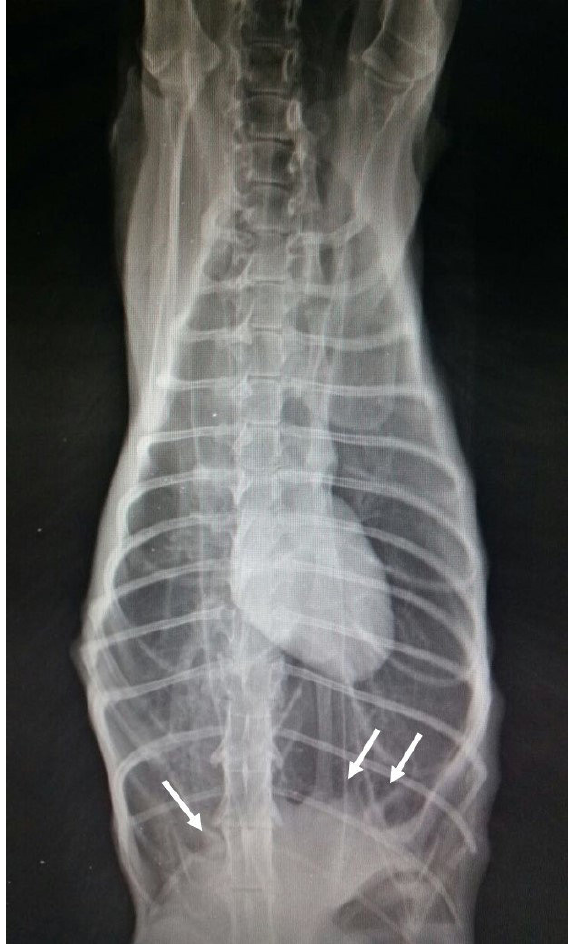
Figura 2. Imagem radiográfica de região torácica na posição ventro-dorsal do paciente relatado, evidenciando aumento da distância da silhueta cardíaca e cúpula diafragmática e presença de protuberâncias diafragmáticas